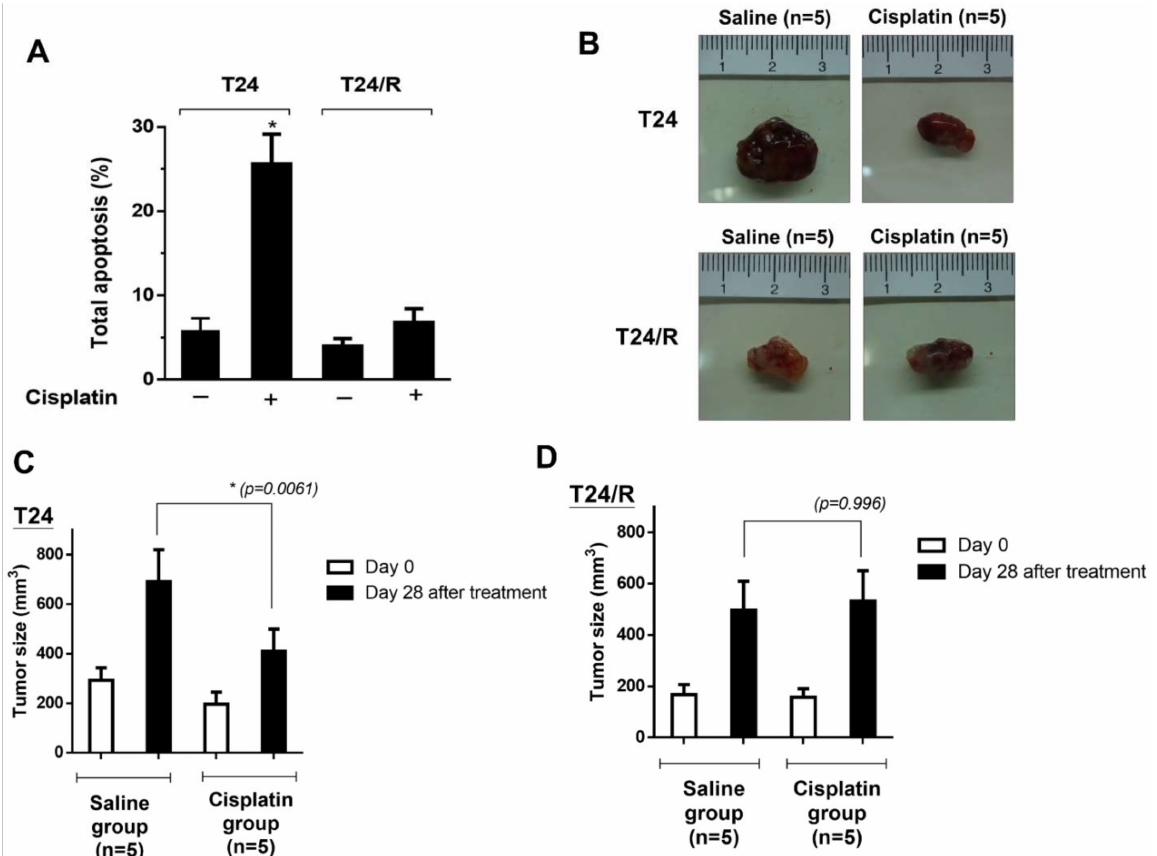
Figure 1. Cisplatin-induced apoptosis was mitigated in cisplatin-resistant urothelial carcinoma cell lines. ( A ) Cells were exposed to cisplatin (15 µ M) and dimethyl sulfoxide for 48 h. Apoptotic cells were analyzed using fluorescence-activated cell sorting flow cytometry with propidium iodide and annexin V-FITC staining. Data are presented as means ± standard deviation (SD); * p < 0.05 represents a significant difference between the indicated groups. ( B – D ) The in vivo xenograft model demonstrated that T24/R cells were resistant to cisplatin. The T24 and T24/R tumor-bearing mice were divided into: saline as untreated control, ( n = 5), and cisplatin-treated (5 mg/kg, n = 5) twice per week for 28 days, respectively. Tumor volumes were measured before treatment and 28 days after treatment. The data are presented as means ± SD; * p < 0.05 represents a significant difference between the indicated